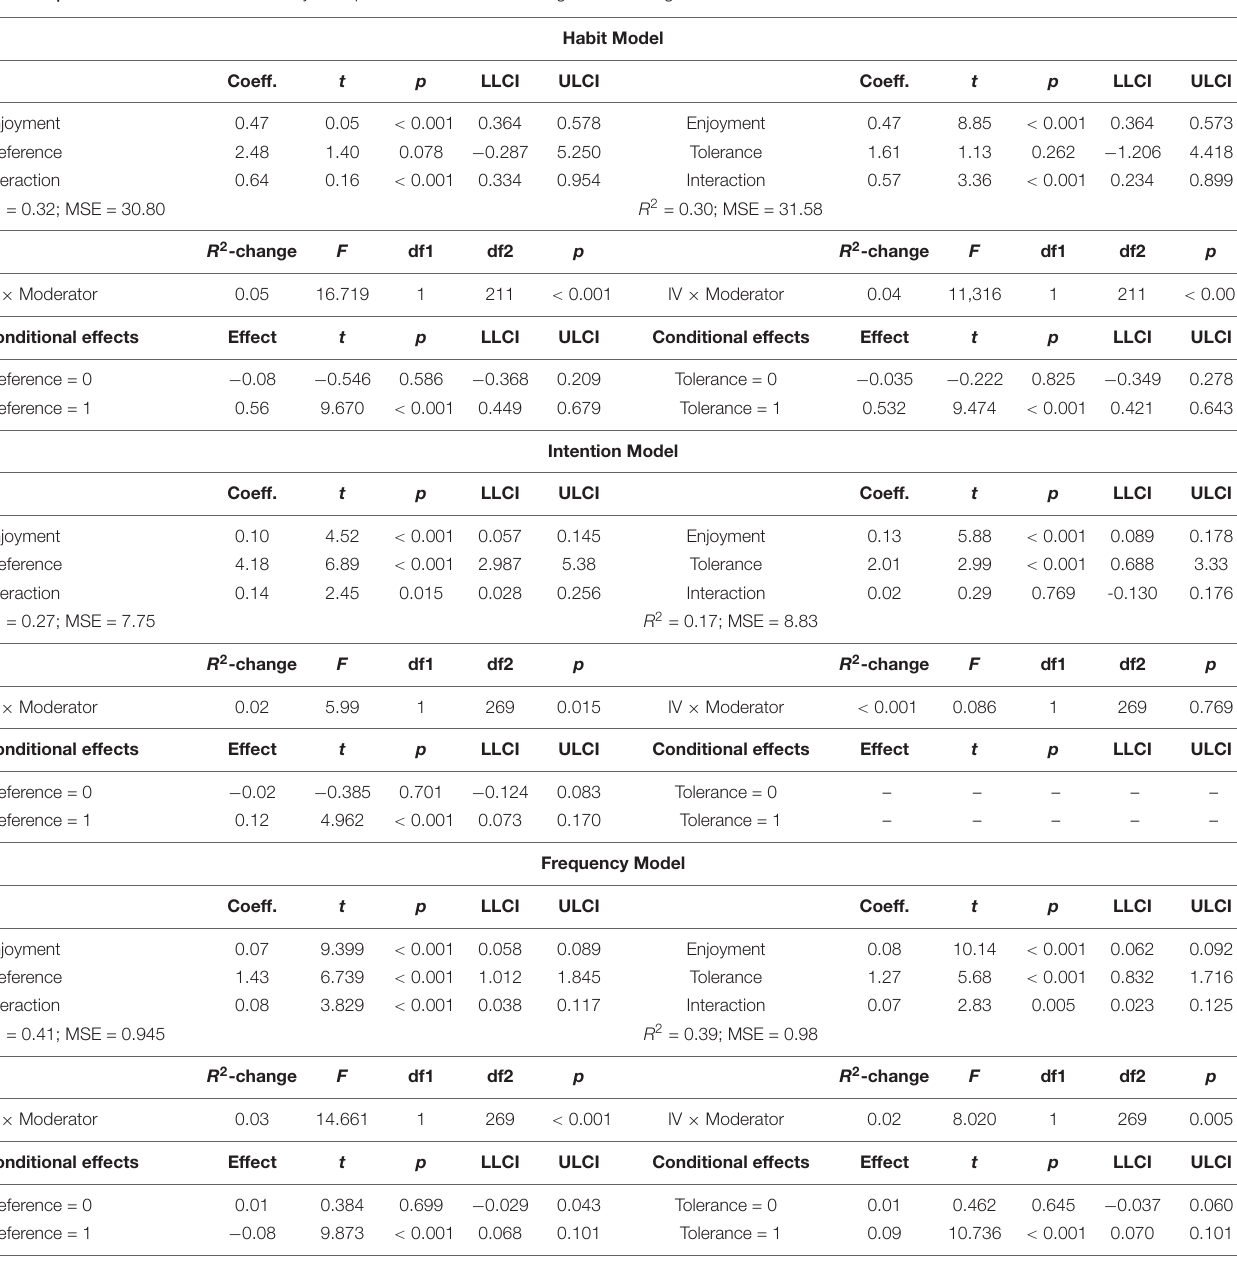
TABLE 2 | Moderation and interaction analysis of preference and tolerance